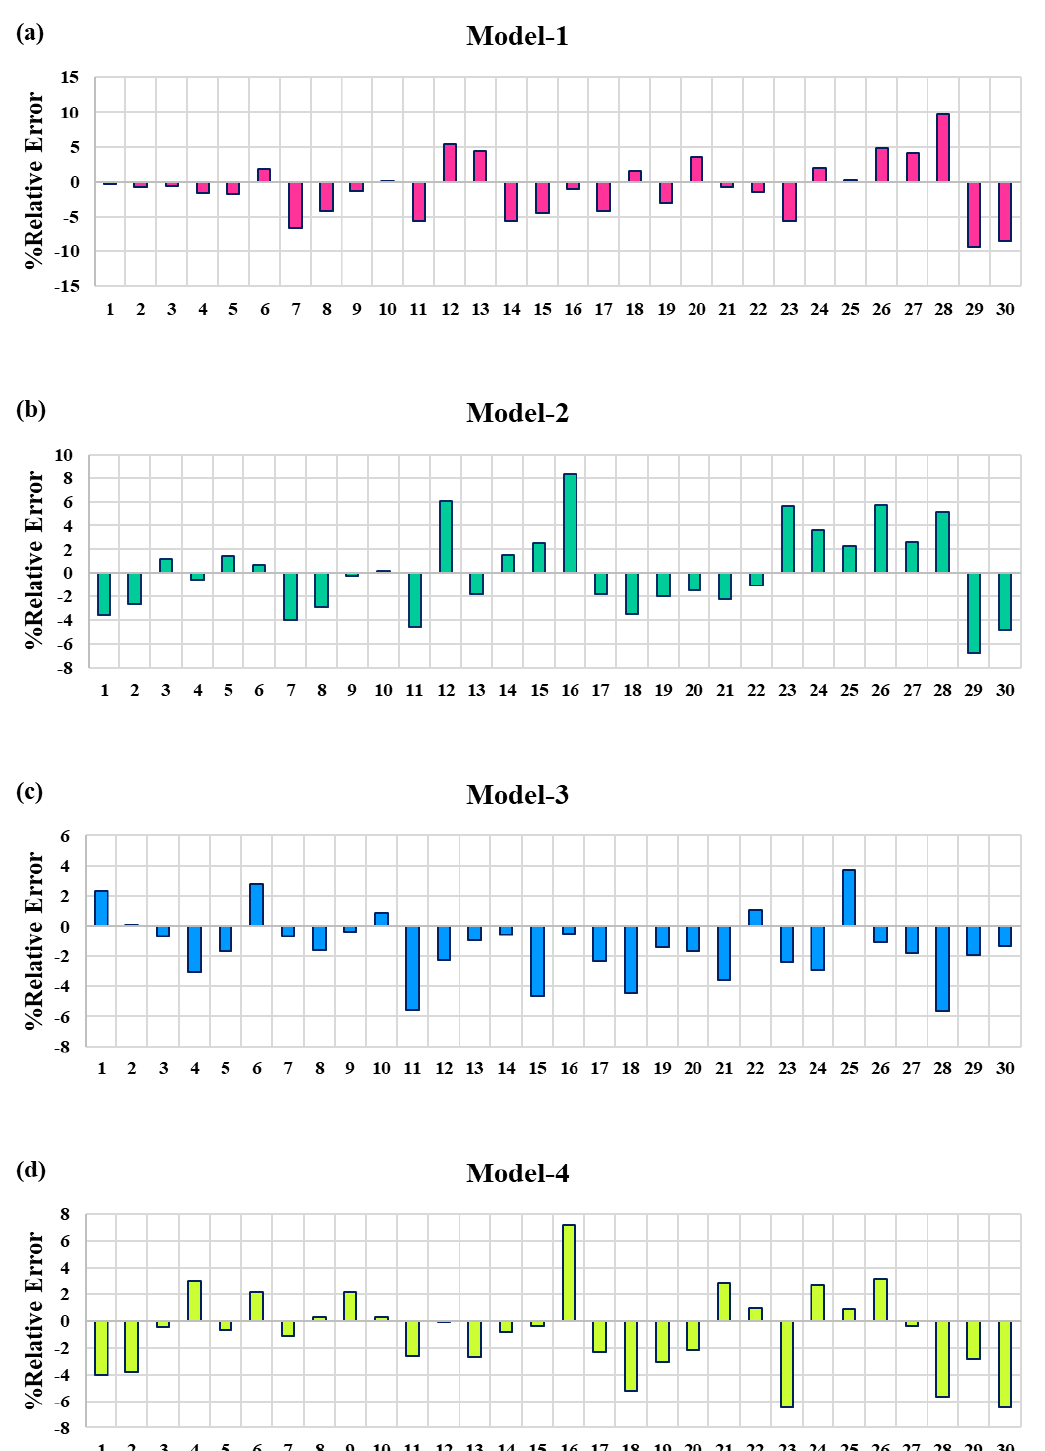
PNN Figure 6. Distribution of the relative error through examination interval for all models using PNN method.